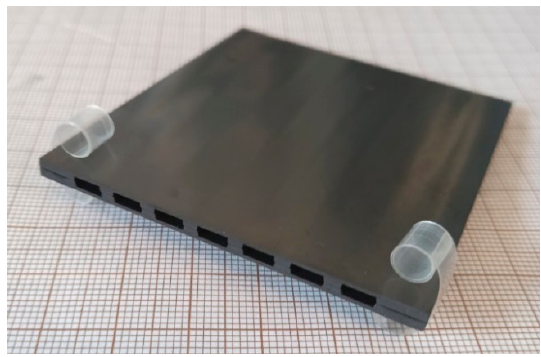
Figure 6. Final membrane component with dimensions of 60 mm× 60 mm.